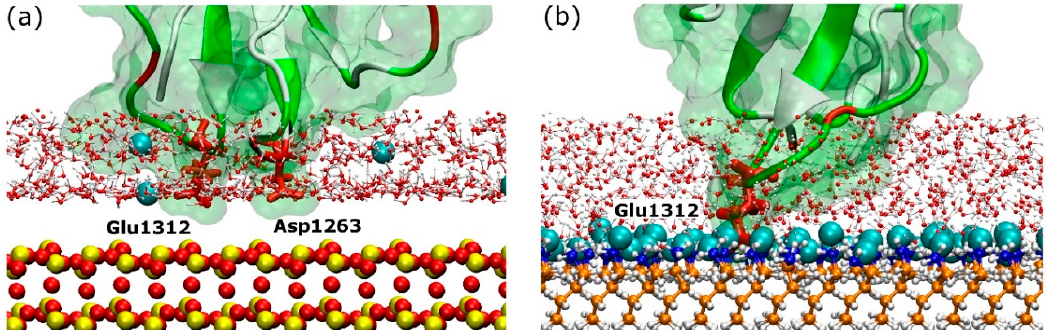
Figure 8. Anchoring site between FNIII 8 module and ( a ) silica, ( b ) amine surface. Anchoring residues are shown by thick red sticks and are annotated, while the surfaces are shown by CPK representation. The colour-coding for the surface is: red–oxygen; yellow–silicon; orange–carbon; white–hydrogen; and blue–nitrogen. The teal spheres represent Cl − ions.